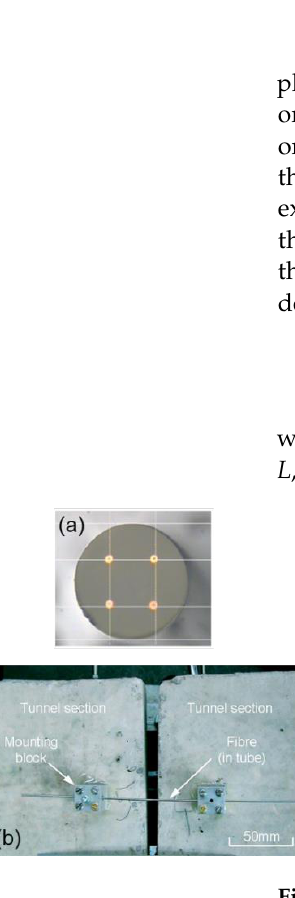
Figure 15. ( a ) Cross-section of the MCF. ( b ) Upper plot, x-deflection measured by MCF FBGs (solid curve) and camera (x). Lower plot, y-deflection measured by sensor (solid curve) and camera (o). Adapted with permission from Ref. [47] © Optica Publishing Group.